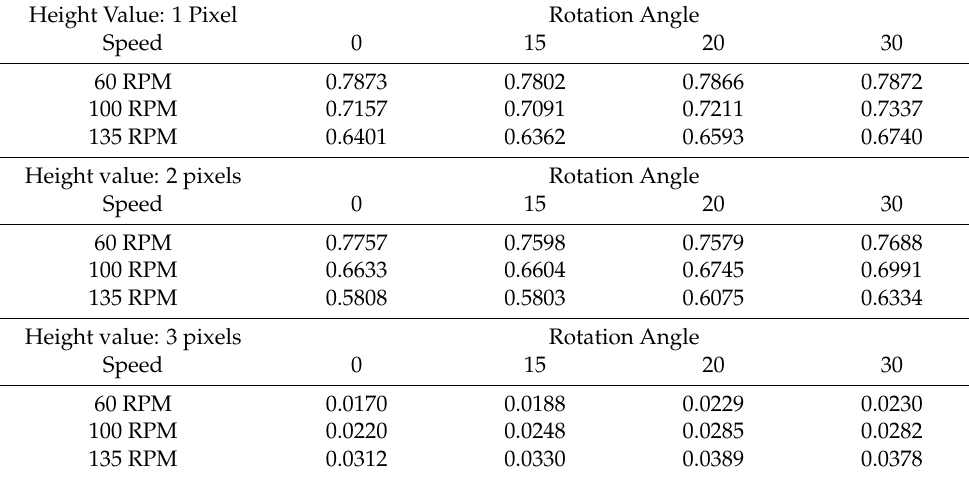
Table 4. Synthetic radial motion blur performance-BF